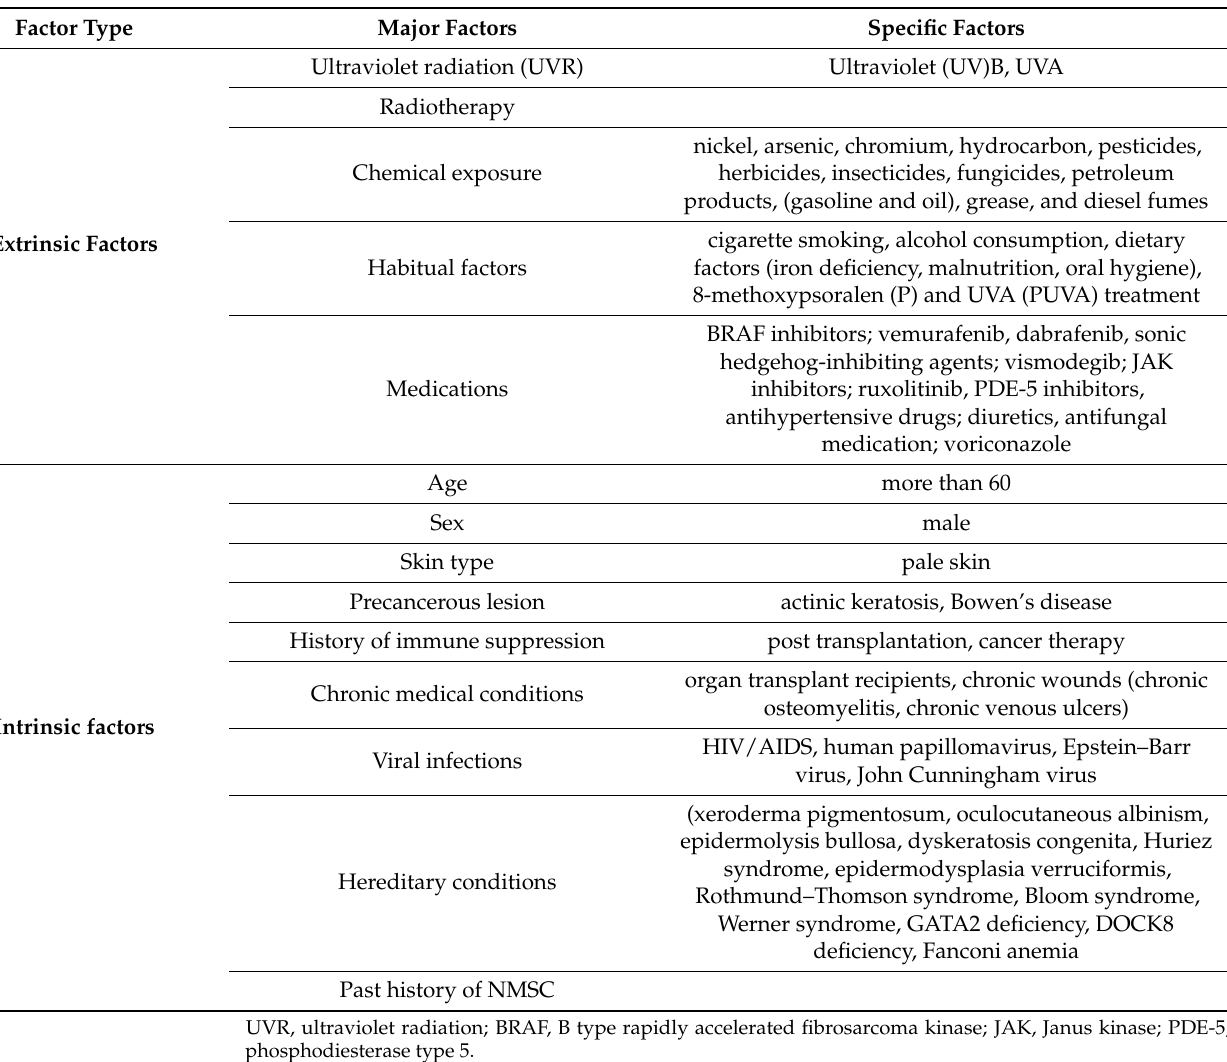
Table 1. Major Risk factors for Squamous Cell Carcinoma.